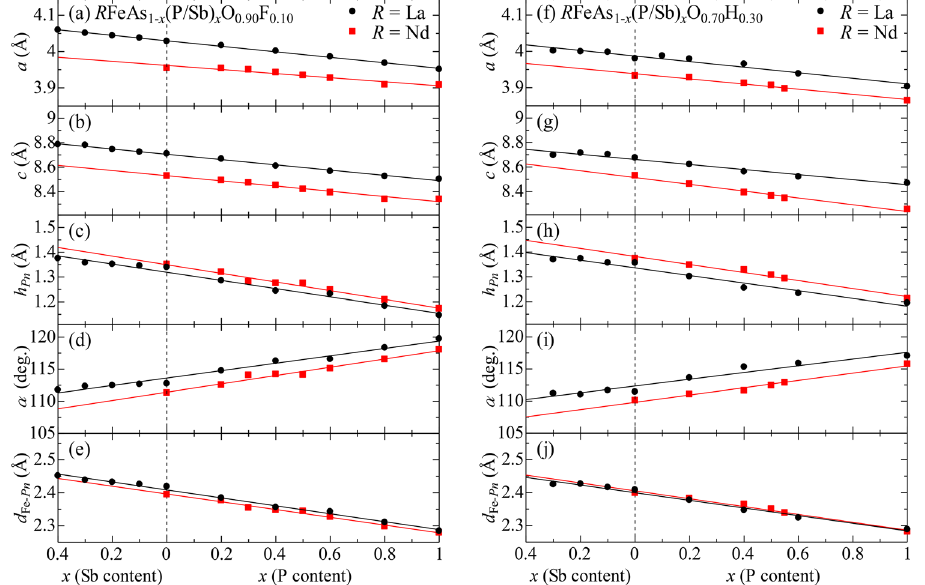
Figure 1. x -dependence of structural parameters for ( a – e ) R FeAs 1 − x (P/Sb) x O 0.90 F 0.10 and ( f – j ) R FeAs 1 − x (P/ Sb) x O 0.70 H 0.30 ( R = La and Nd). ( a , f ) Lattice constant a . ( b , g ) Lattice constant c . ( c , h ) Pnictogen height from the Fe plane, h Pn . ( d , i ) Pn –Fe– Pn bond angle α . ( e , j ) Fe– Pn bond length d Fe − Pn . Structural parameters for other compositions are shown in Supplementary Information (Fig.